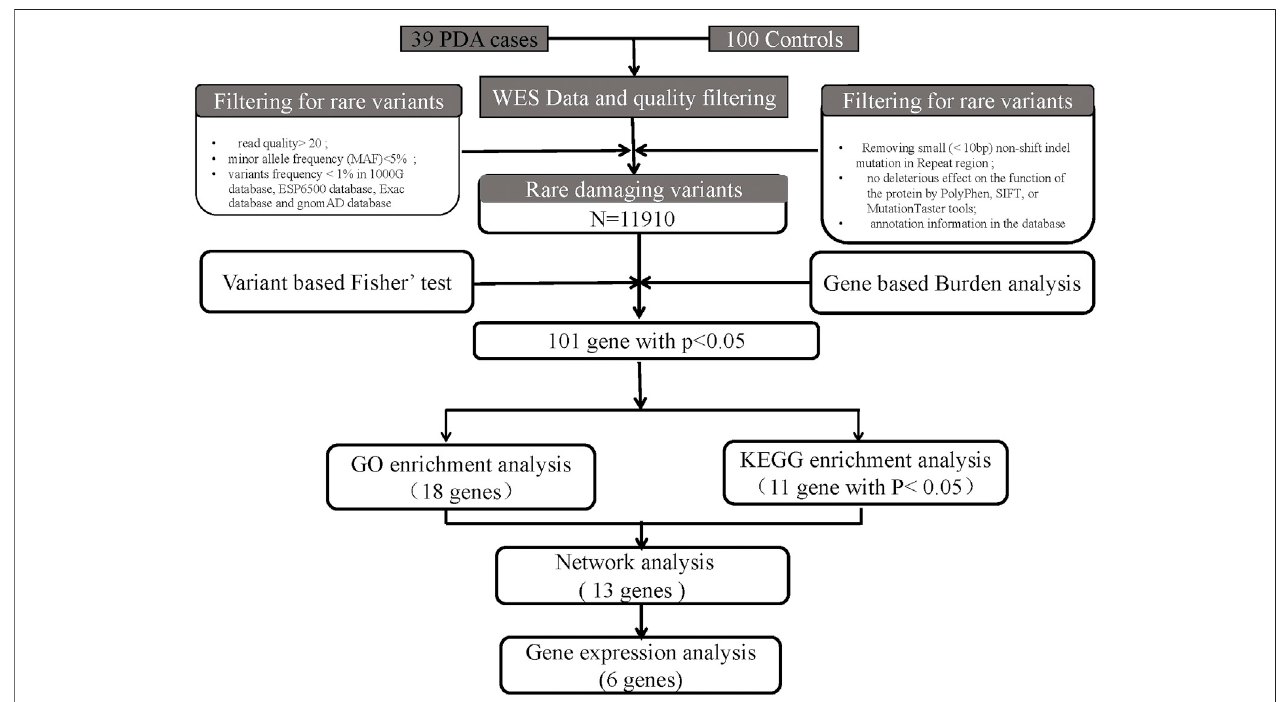
FIGURE 1 | Bioinformatics fi ltering strategy work fl ow for the candidate genes. Through a series of fi ltering methods, we fi nally identi fi ed 6 candidate genes. The potentially damaging variants in candidate genes were subjected to validation via human embryonic heart expression analysis.